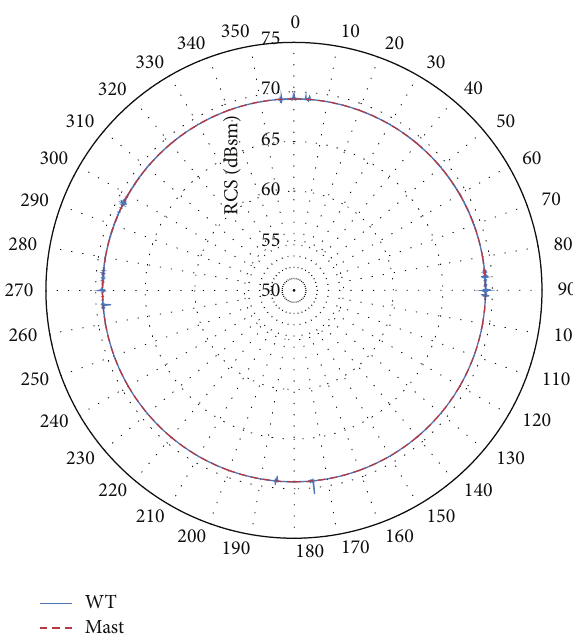
Figure 7: Variation in the horizontal plane of the RCS pattern for the maximum RCS value of the vertical pattern (incidence normal to the mast surface). Wind turbine (blue line) and mast (red dotted line) RCS patterns for turbine model 3 at 9.945